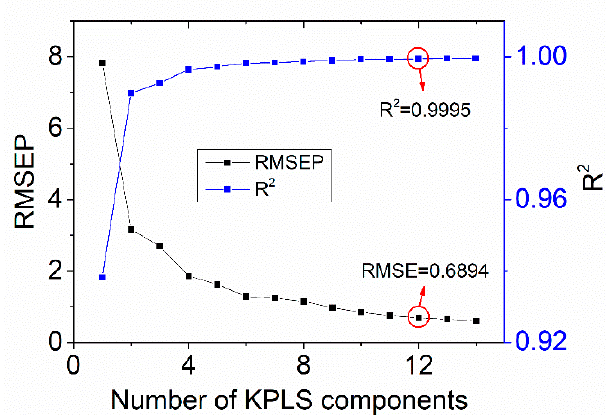
Figure 7. Relationship between principal component number and root mean square errors of the prediction (RMSEP), R 2 . prediction (RMSEP), R 2